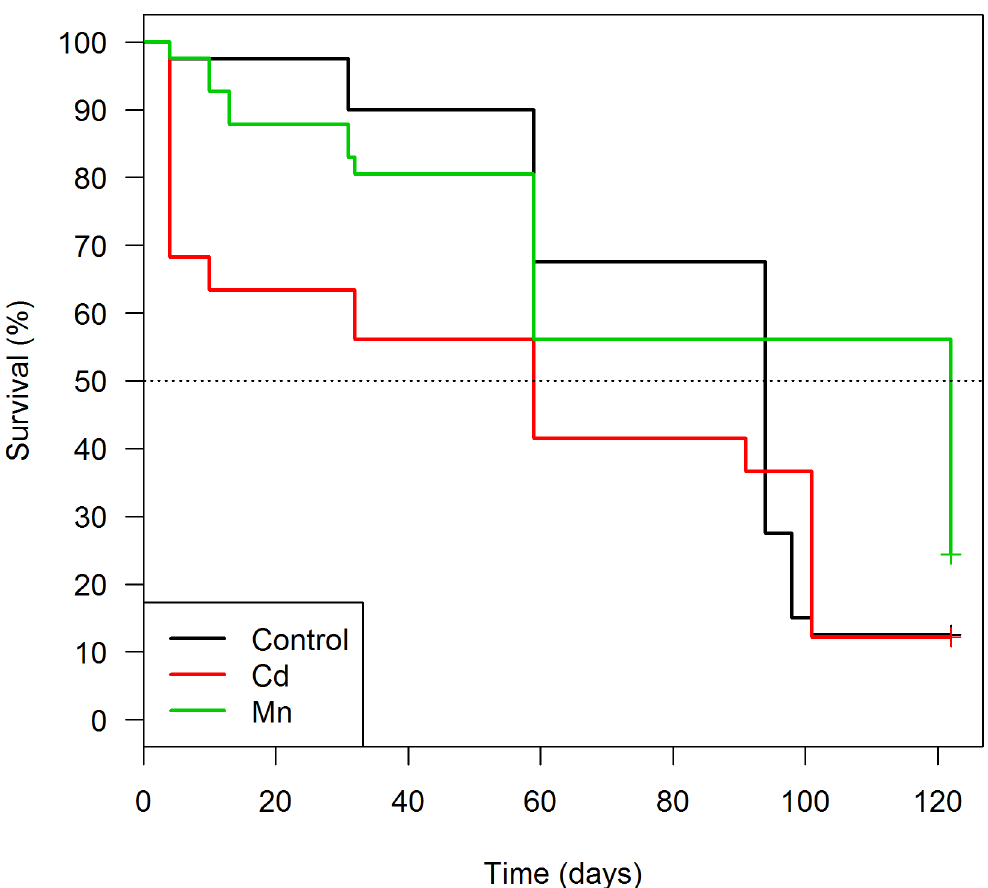
Fig 5. Survival analysis of Rhodnius nasutus fed with sheep blood enriched with one of the following trace elements: Cd (N = 41), Mn (N = 41) and control group (N = 40).